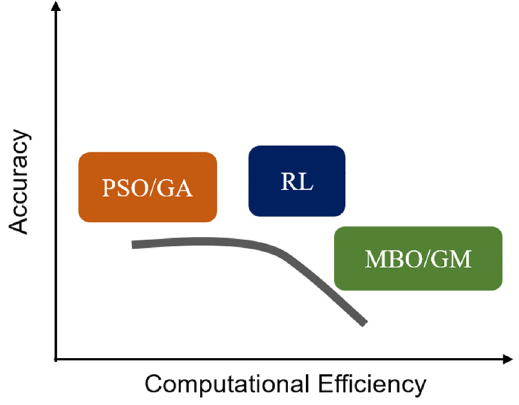
Figure 18: Comparison between different inverse design methods for structural color generation in terms of accuracy and computational